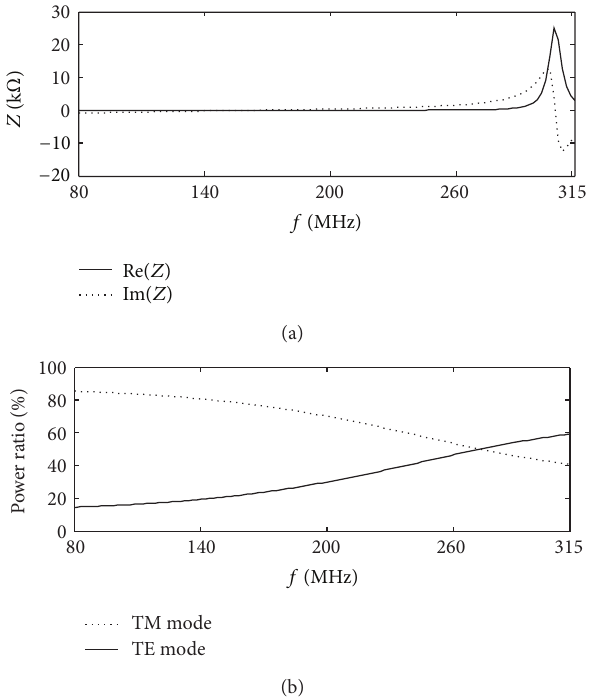
Figure 3: Impedance and power ratio of single-arm PEC SS-SHA.